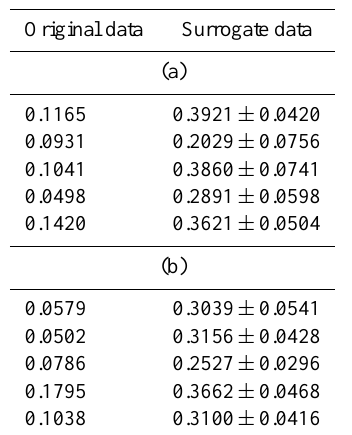
Figure 11. Fraction of false nearest neighbours plotted against the time embedding dimension for the original detrended data (blue curve) with the mutual information for the surrogate data (red curve) for TEC data measured at Lagos for the quietest day of 20 March. Table 2. (a) Results of surrogate data tests for Lyapunov exponents for TEC data for the quietest days of October 2011 at Birnin Kebbi station. (b) Results of surrogate data tests for Lyapunov exponents for TEC data for the most disturbed days of October 2011 at Birnin Kebbi